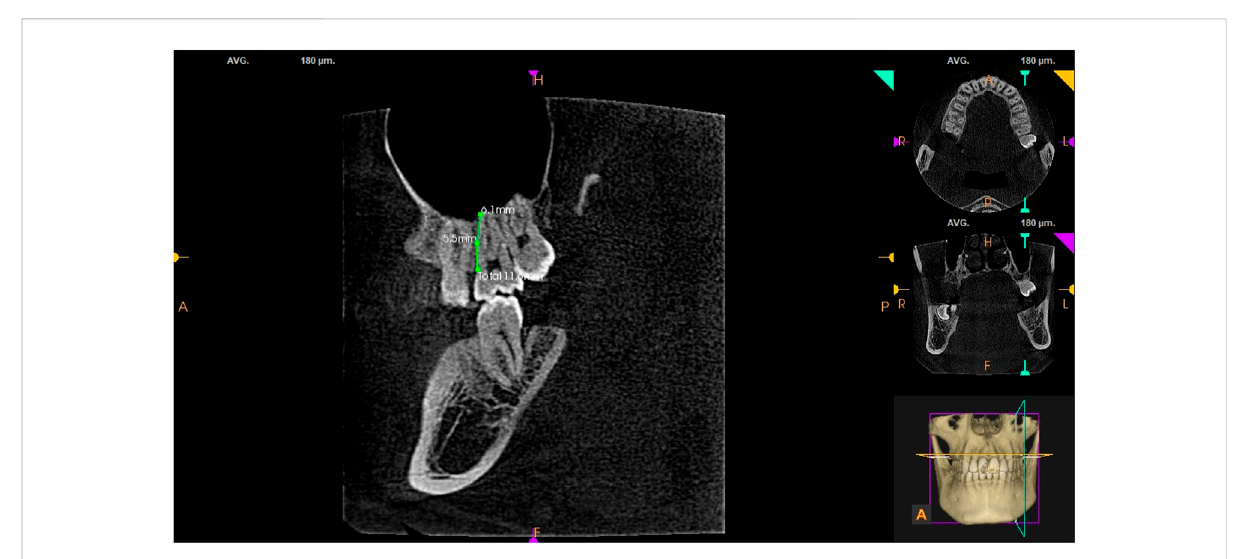
FIGURE 2 Length of MB root in maxillary second